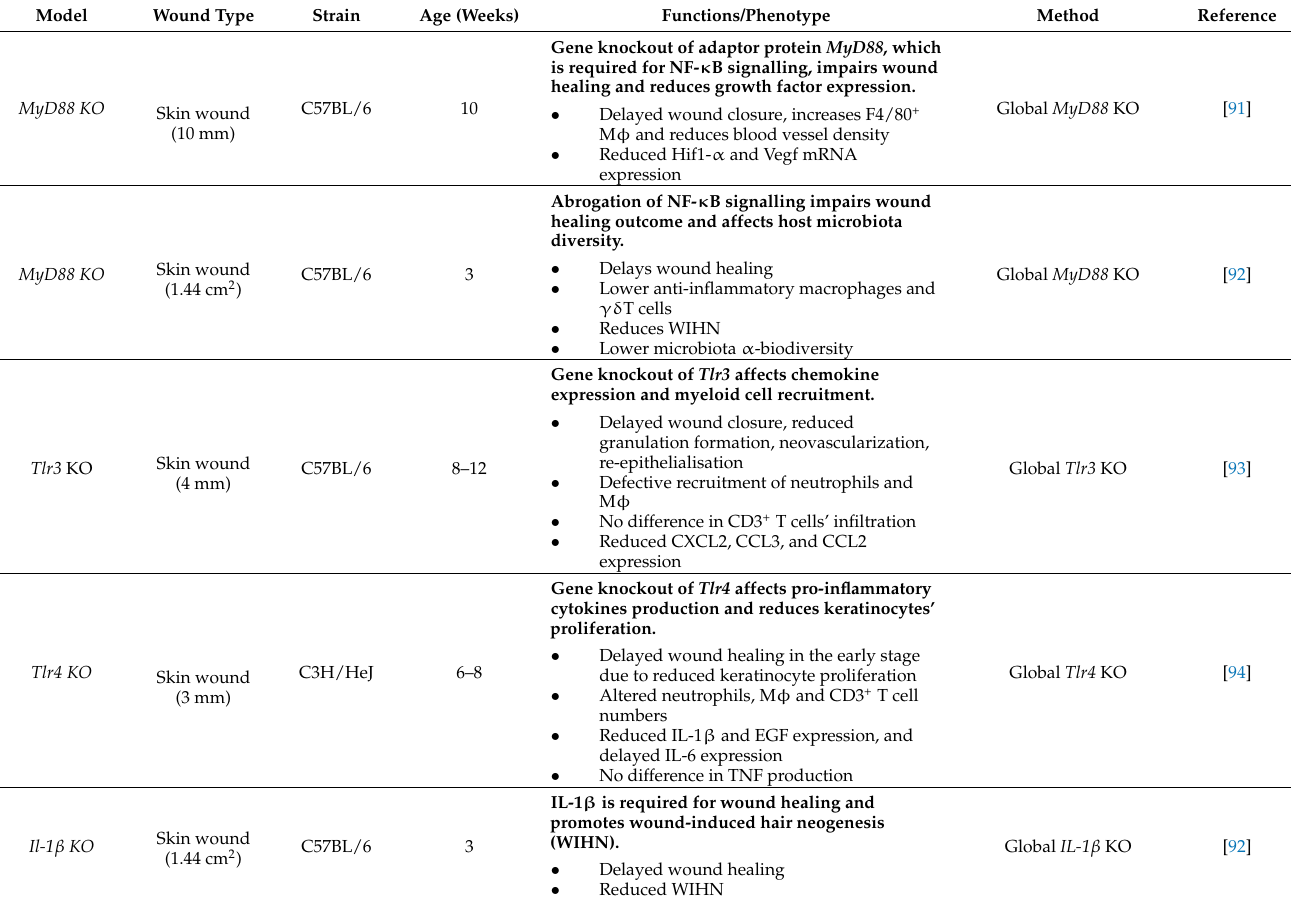
Table 2. Immunoregulatory role of different cytokines and pro-inflammatory signalling on wound